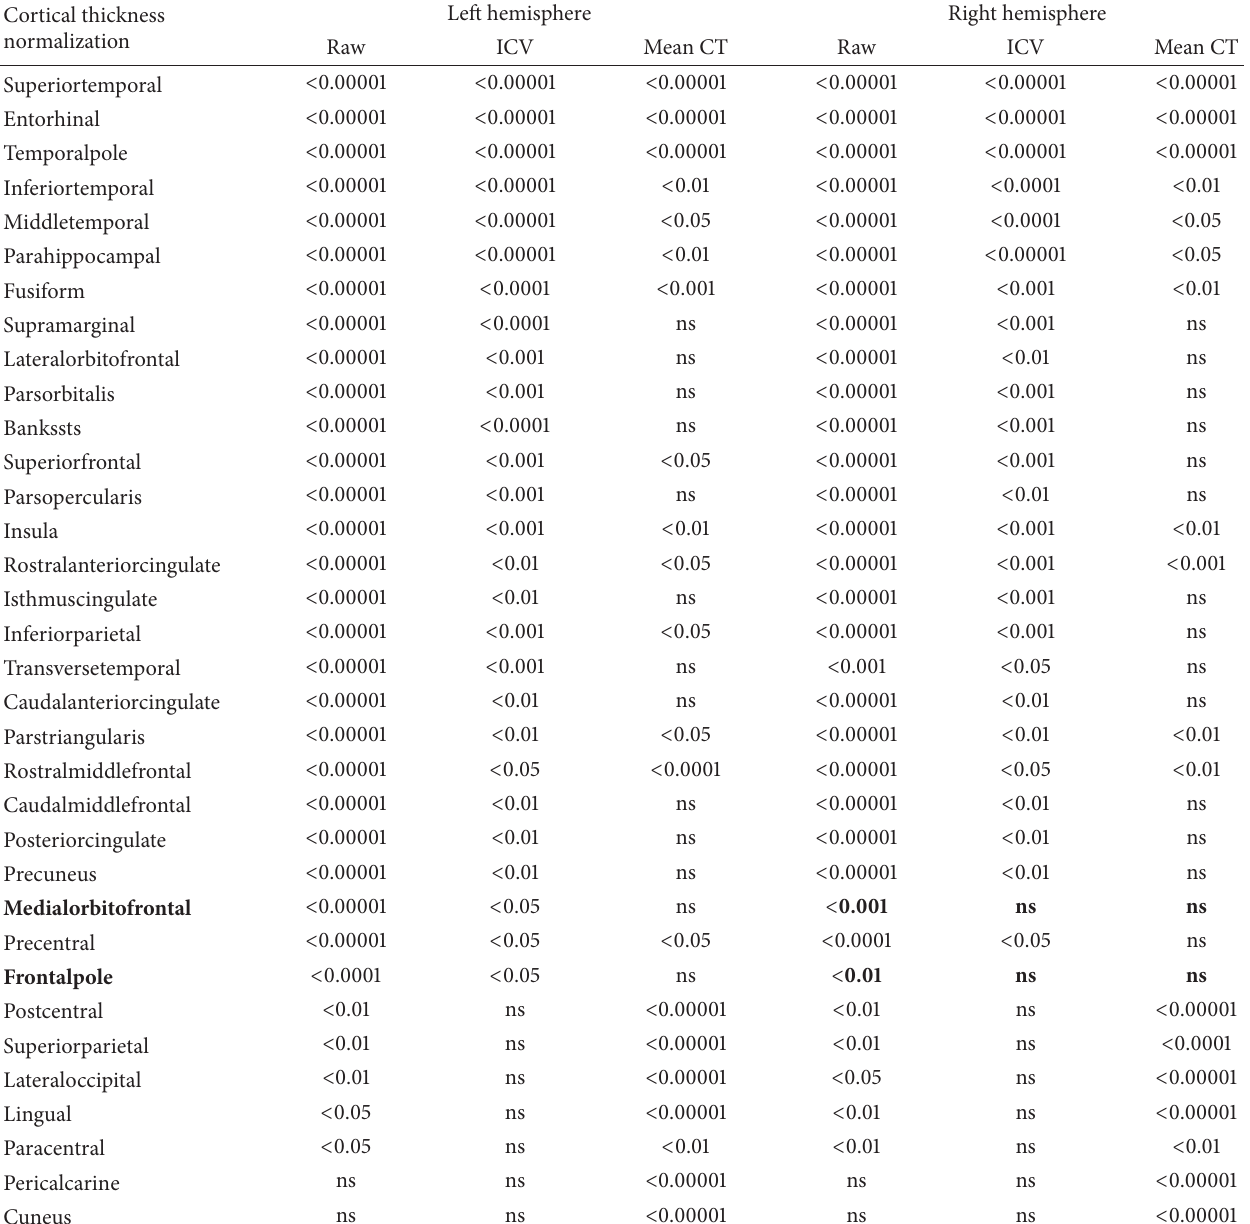
Table 8: Univariate analysis of cortical thickness for left and right hemispheres ∗